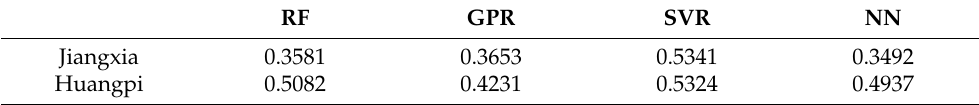
Table 2. Model performance of each machine learning model of Jiangxia and